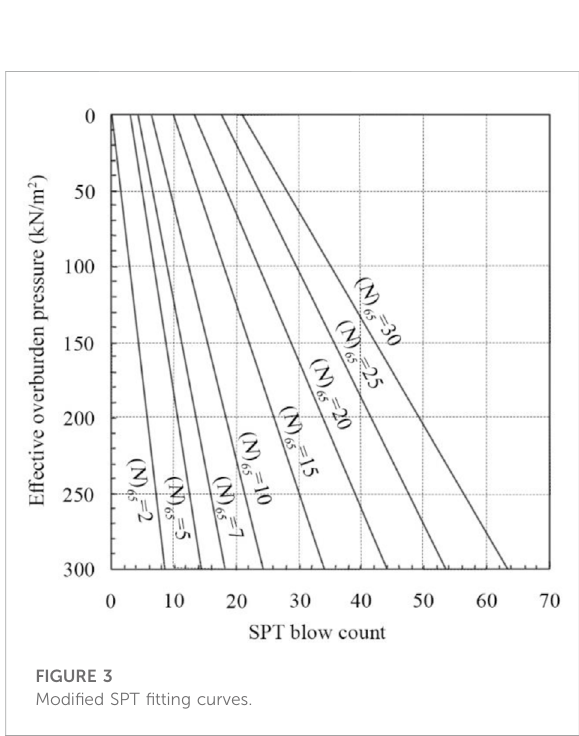
FIGURE 3 Modi fi ed SPT fi tting